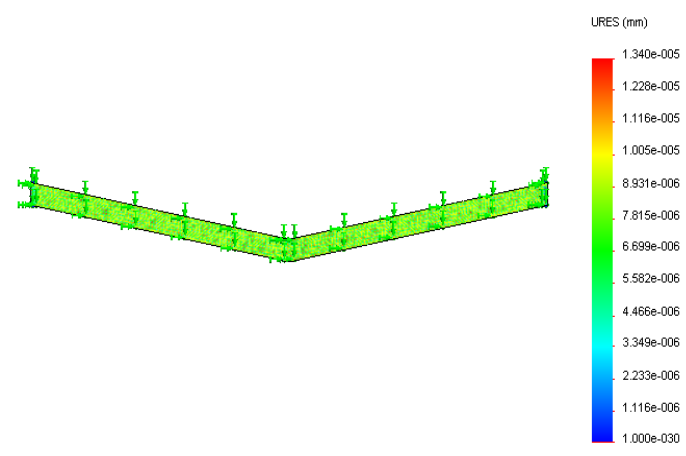
Figure 10. Displacement (in mm) of the silver tracing at 423 K.